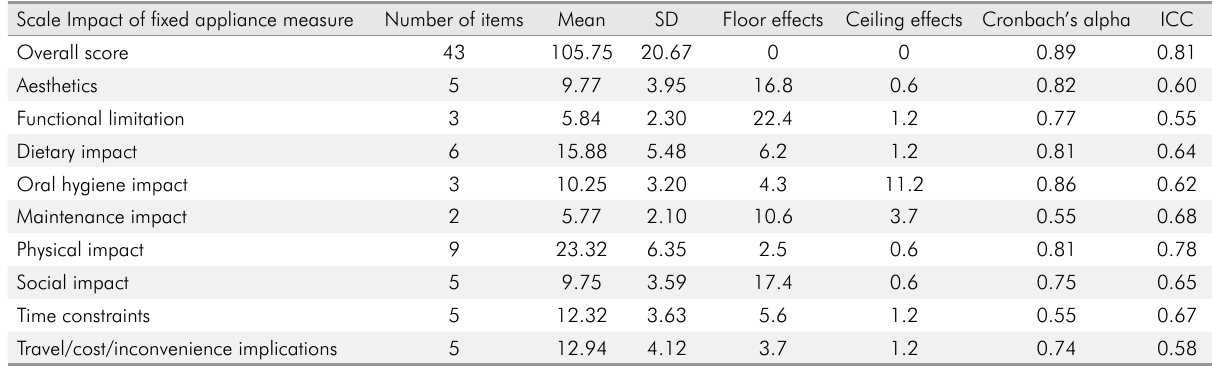
Table 2. Descriptive analysis and reliability of the B-IFAM to assess the impact of fixed appliances on daily life. Scale Impact of fixed appliance measure